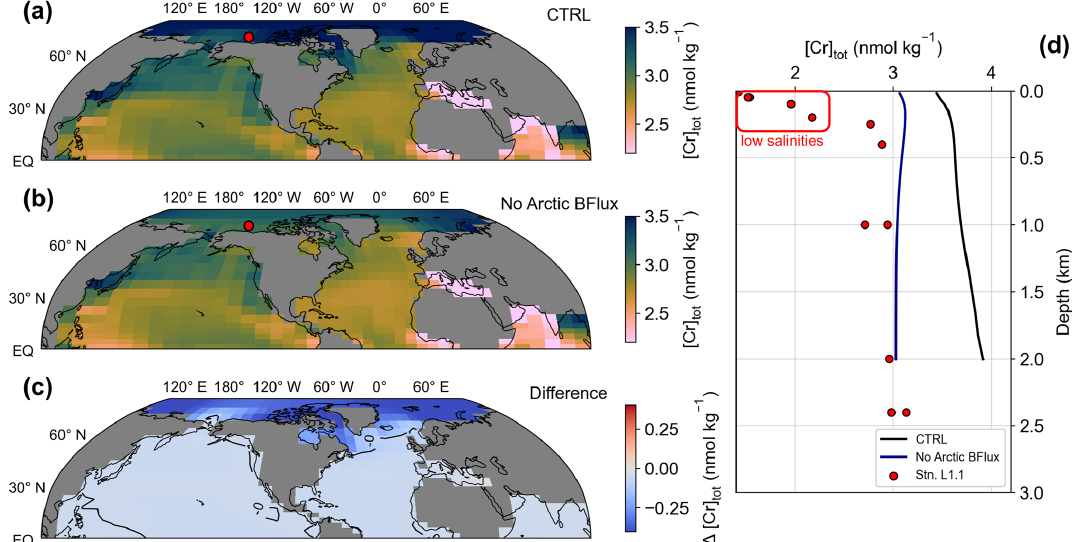
Figure 4. (a–c) Surface total Cr concentrations for simulations CTRL and NoArcticBFlux, as well as the difference between both. The red circle marks the location of station L1.1 of Scheiderich et al. (2015) depicted in (d) . (d) [Cr] tot depth transect from the Arctic. Lines represent model output of simulations CTRL (black) and NoArcticBFlux (blue) of the grid cells closest to station L1.1 (red